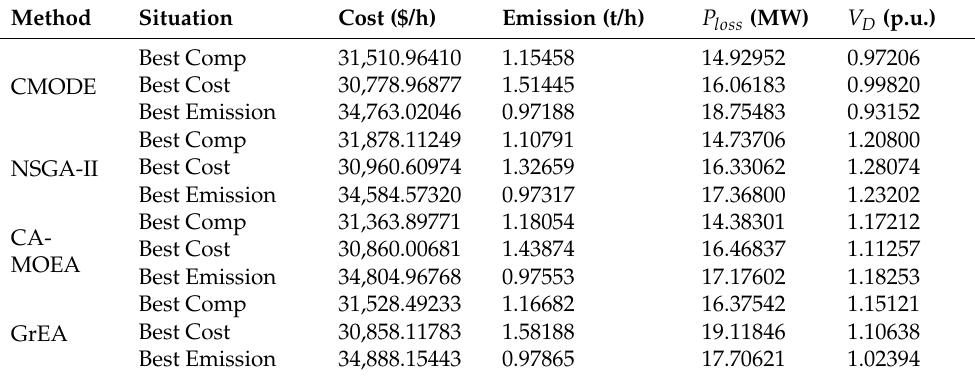
Table 7. The comparison of part of solutions in case